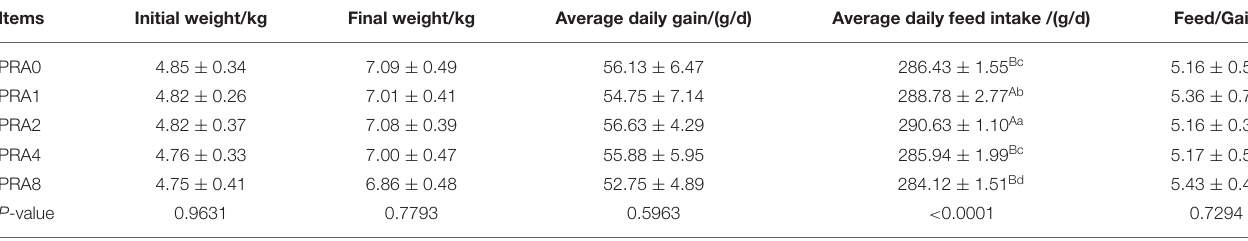
TABLE 2 | Effects of dietary PRA extract levels on growth performance of raccoon dog.